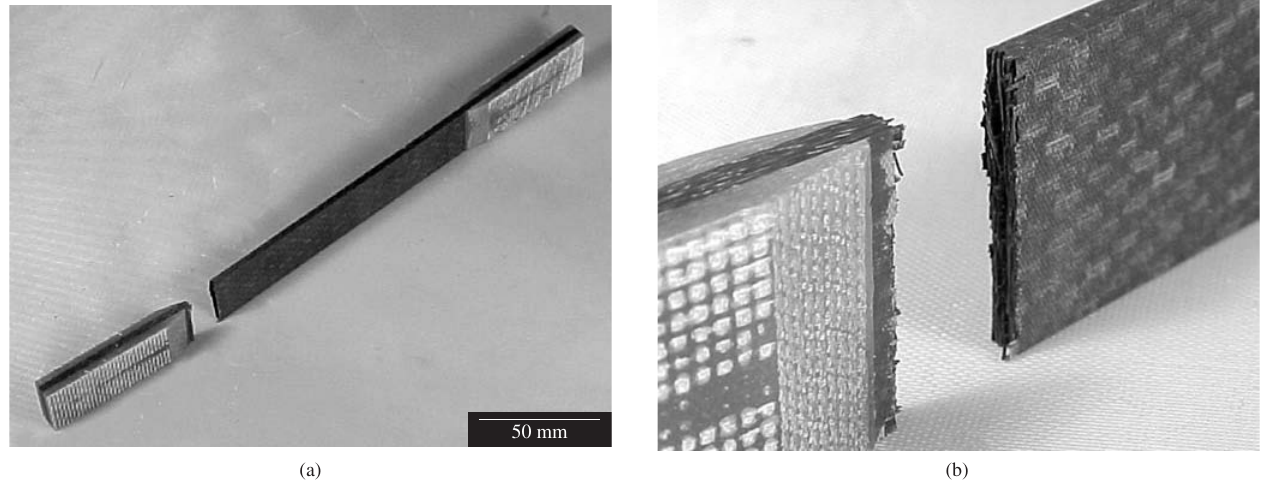
Figure 5. F155/8HS laminate: a) specimen tested; and b) detail of the failure mode type LAB ( Lateral At grip/tab Bottom ).